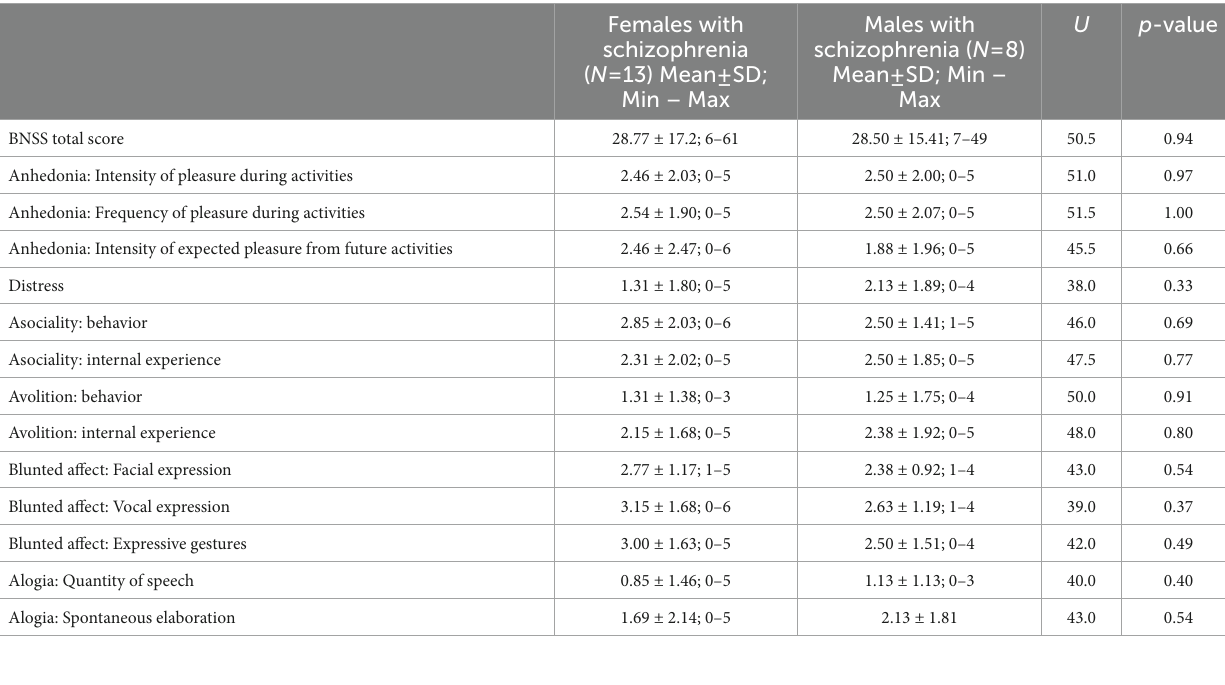
TABLE 6 BNSS scores in females and males.